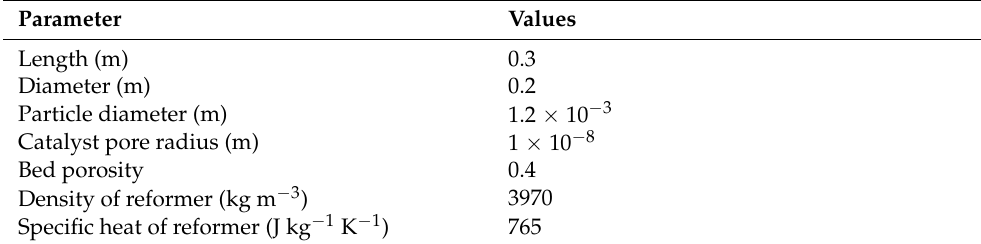
Table 5. Reformer specifications.